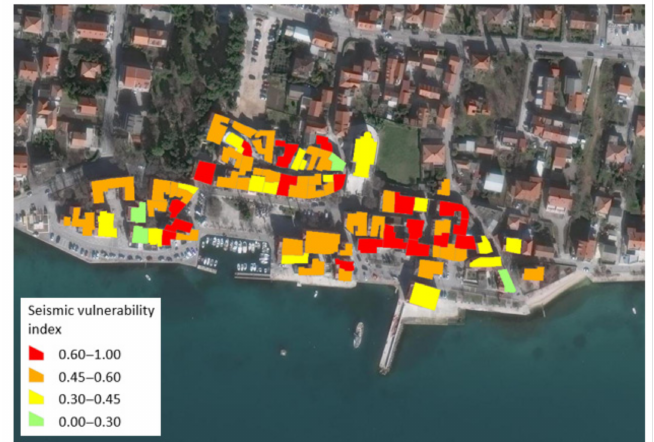
Figure 7. Vulnerability map of the historical core.